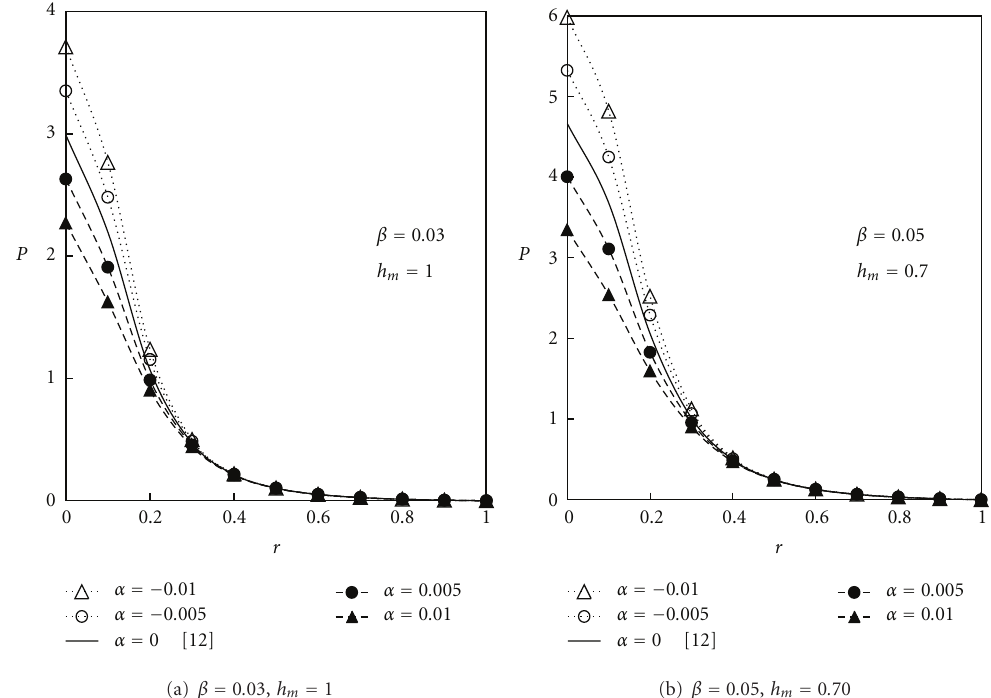
Figure 2: Variation of dimensionless pressure with respect to the dimensionless radius r for di ff erent values of pseudoplastic parameter α